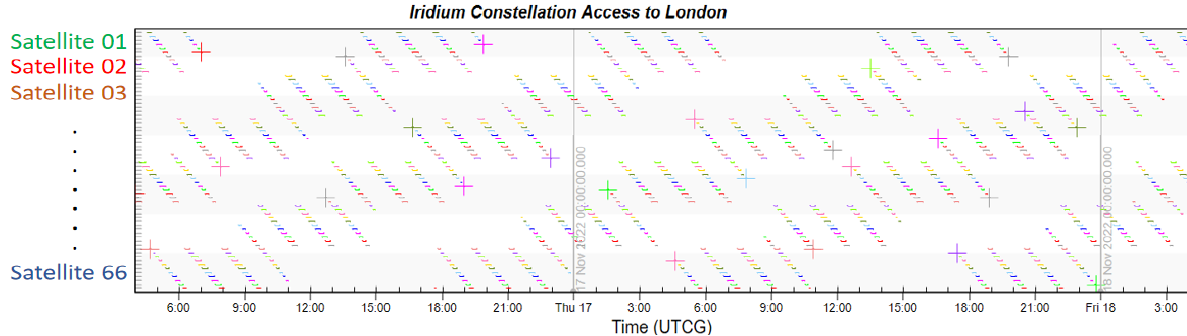
Figure 13. Iridium constellation access to London.